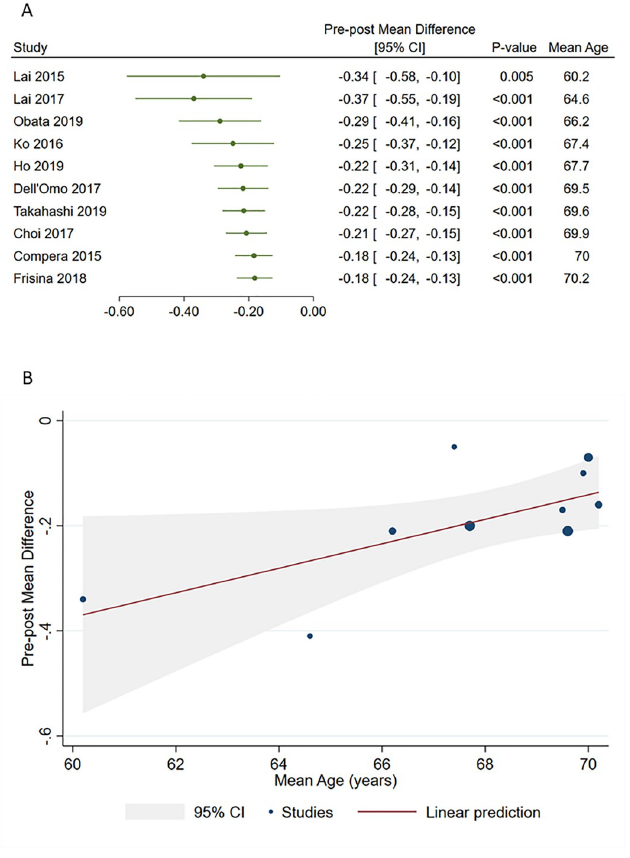
Fig 4. Cumulative meta-analysis (A) and meta-regression (B) showing relationship between patient age and pre- post mean difference in BCVA in the degenerative LMH and LHEP group.